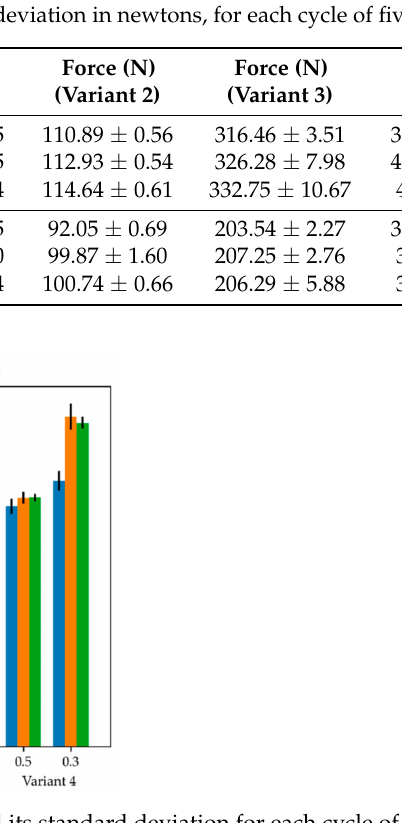
Figure 3. Bar chart of mean peak force and its standard deviation for each cycle of five actuations of the eight sensor variants at different speeds and for the gap sizes of 0.5 mm and 0.3 mm (see Figure